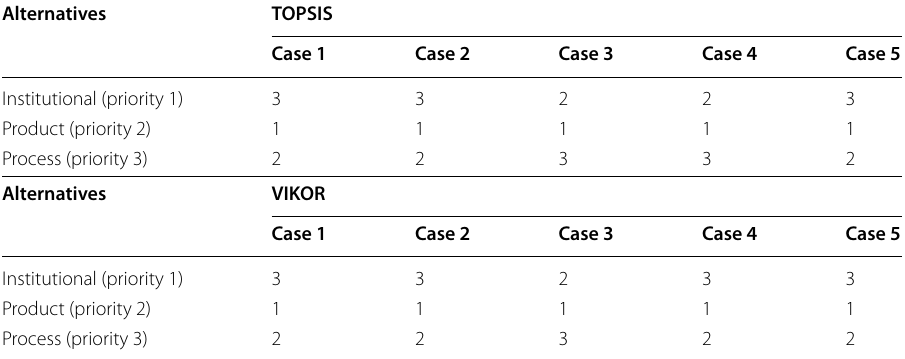
Table 12 Comparative results of final ranking alternatives with sensitivity analysis